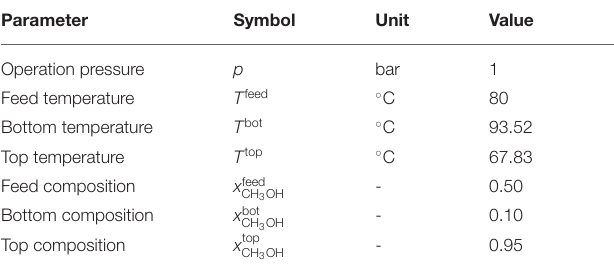
TABLE 2 | Definition of scenario.